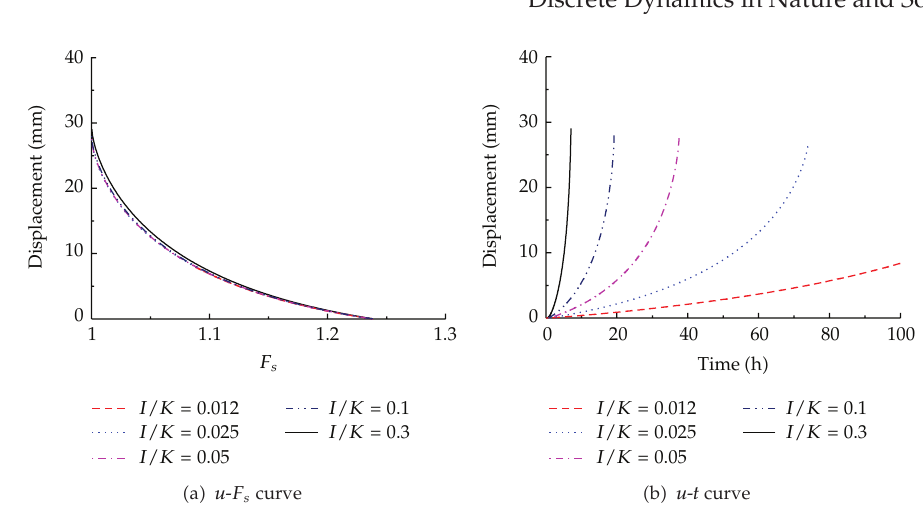
Figure 3: The e ff ect of rainfall on displacement and F s